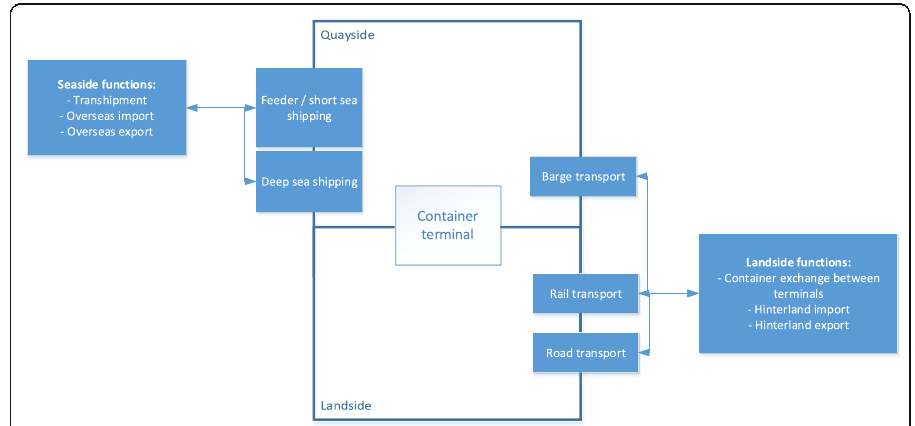
Fig. 1 Processes at and around a deep-sea container terminal. Source: Authors ’ own